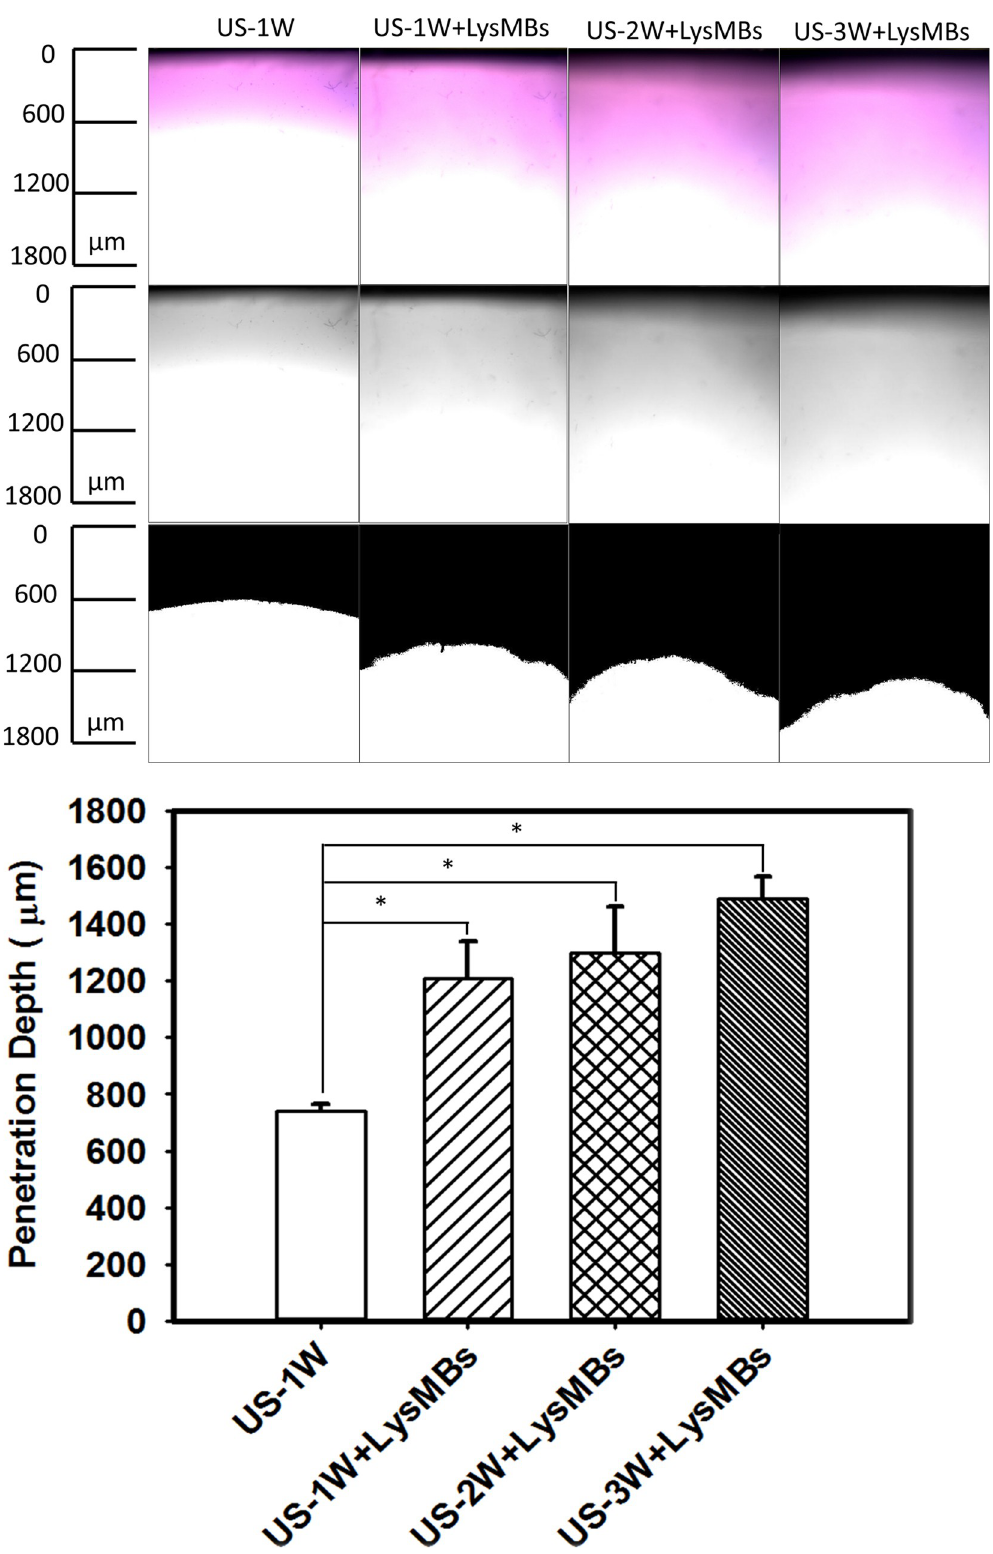
Fig 5. (A) Light microscope evaluation of agarose phantoms that had been treated as indicated. (B) Quantification of the penetration depth of Evans blue. Data represent the mean values and standard deviations. � p < 0.05. https://doi.org/10.1371/journal.pone.0232617.g005 PLOS ONE | https://doi.org/10.1371/journal.pone.0232617 May 21,